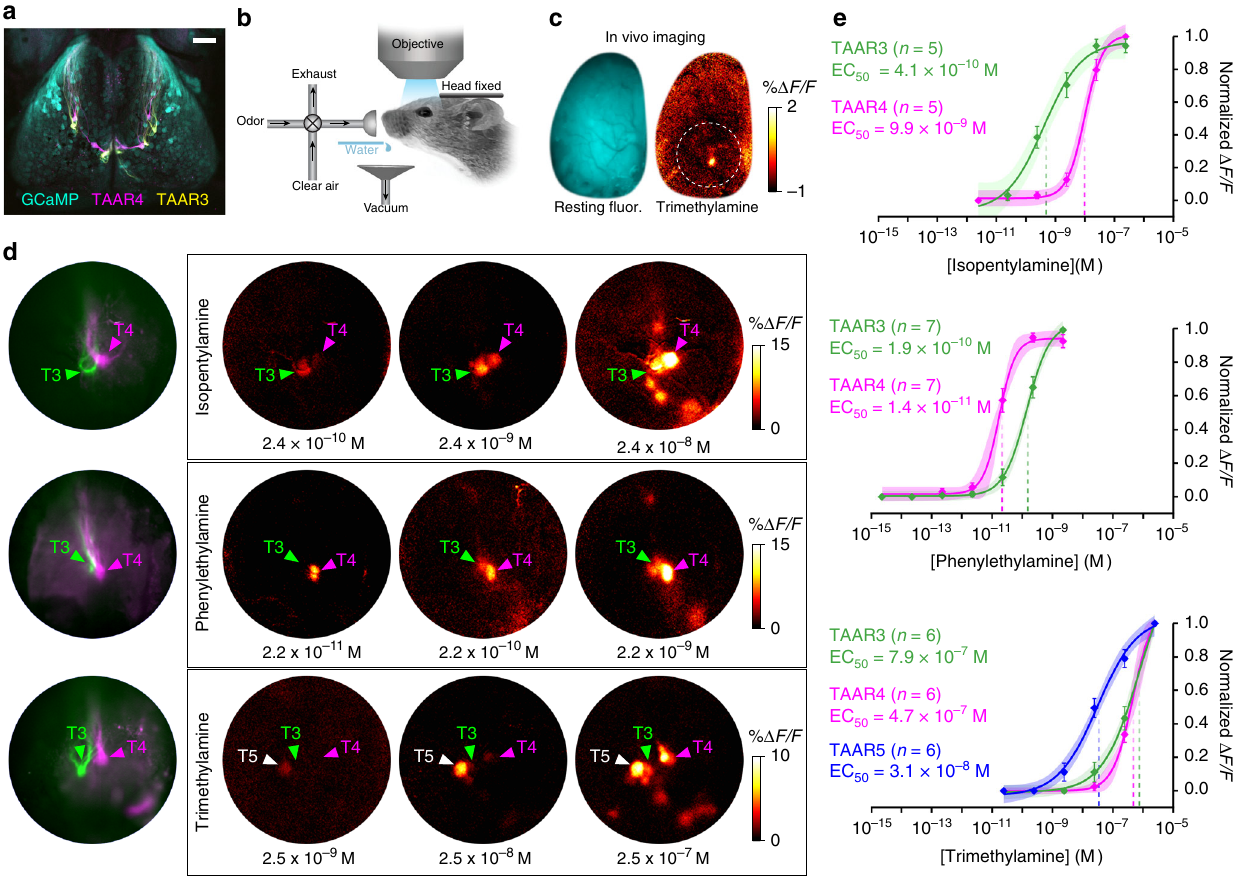
Fig. 2 TAAR glomeruli are the most sensitive amine receptors in the dorsal olfactory bulb. a Confocal image of the dorsal olfactory bulbs from a compound heterozygous OMP-GCaMP3/TAAR3-YFP/TAAR4-RFP mouse. Anterior is up. b Schematic of set-up for wide- fi eld in vivo calcium imaging in head- fi xed, awake mice. Odors are delivered using a fl ow dilution olfactometer, and mice receive water rewards after odor trials. c Wide- fi eld fl uorescence image of an olfactory bulb showing resting GCaMP fl uorescence (cyan) and response in a single glomerulus to trimethylamine (warm colors) in an awake mouse. Circle shows the general region of the olfactory bulb imaged at higher magni fi cation in all experiments. d Higher-magni fi cation imaging of odor-evoked activity from TAAR glomeruli in the dorsal olfactory bulbs. (Left) Resting fl uorescence shows genetically tagged TAAR3 (green) and TAAR4 (magenta) glomeruli in three different mice. (Right) Odor-evoked GCaMP responses to amines. Medial is to the right. Locations of tagged glomeruli are marked with colored arrows. Locations of TAAR5 glomeruli, based on response pro fi le, are marked with white arrows. e Dose – response curves from individual TAAR glomeruli to isopentylamine (top), phenylethylamine (middle), and trimethylamine (bottom). Plots show mean + / − SE with a shaded 95% con fi dence interval. Data were fi tted to a Hill function. Isopentylamine: TAAR3 EC 50 = 4.1 × 10 − 10 M (95% CI = 1.3 – 9.9 × 10 − 10 M); TAAR4 EC 50 = 9.9 × 10 − 9 M (95% CI = 6.9 – 14 × 10 − 9 M). Phenylethylamine: TAAR4 EC 50 = 1.4 × 10 − 11 M (95% CI = 1.5 – 2.4 × 10 − 11 M); TAAR3 EC 50 = 1.9 × 10 − 10 M (95% CI